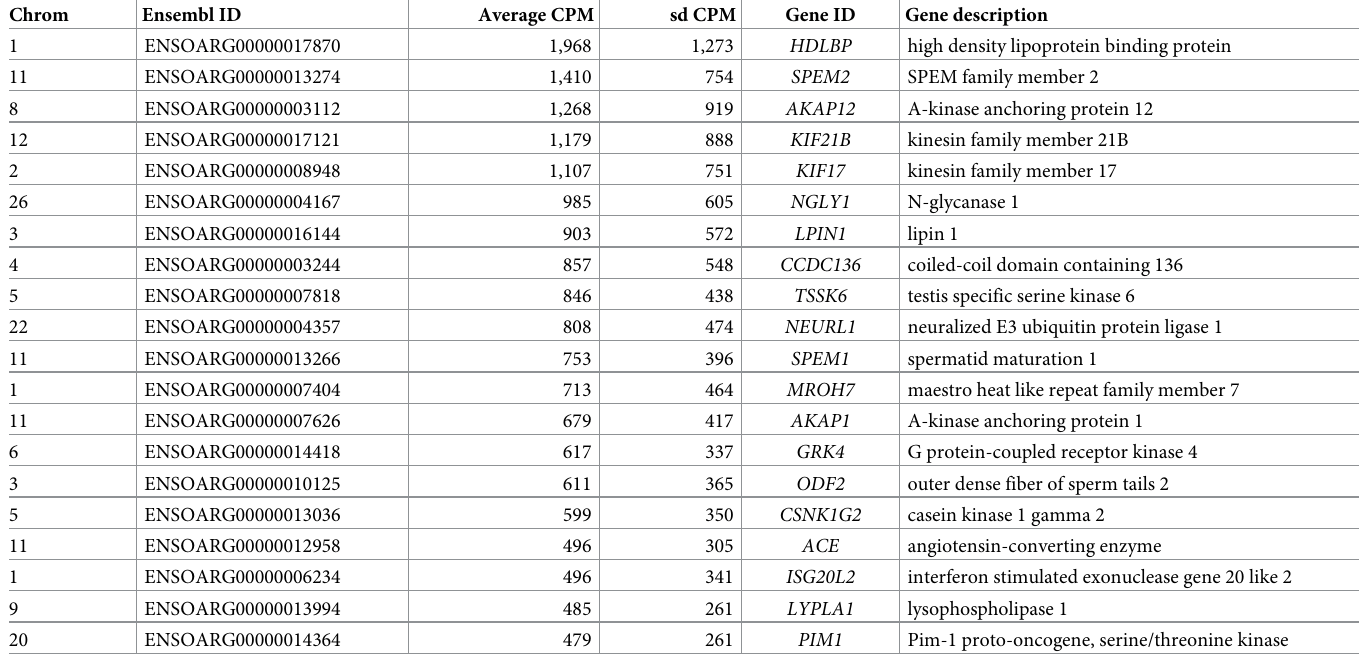
Table 4. Twenty most abundant protein coding genes detected in rams sperm samples.